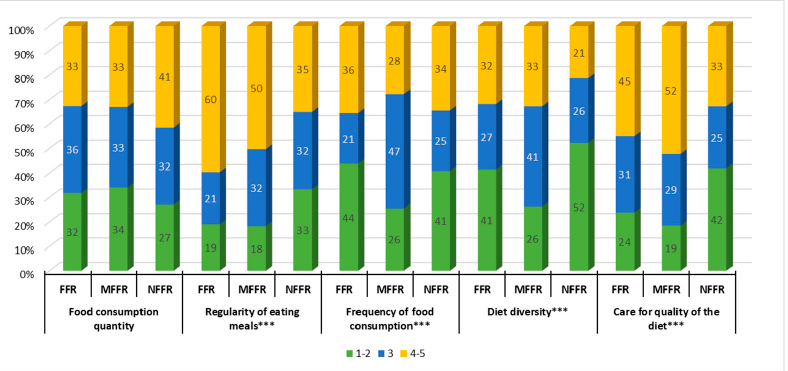
Figure 3. Changes in eating patterns. FFR—Fearing and following the rules, MFFR—Moderately fearing and following the rules, NFFR—Not fearing and not following the rules. The direction of changes: 1—much less, 2—less, 3—no changes, 4—more, 5—much more, Statistically significant in the chi-square test at: *** < 0.0001.